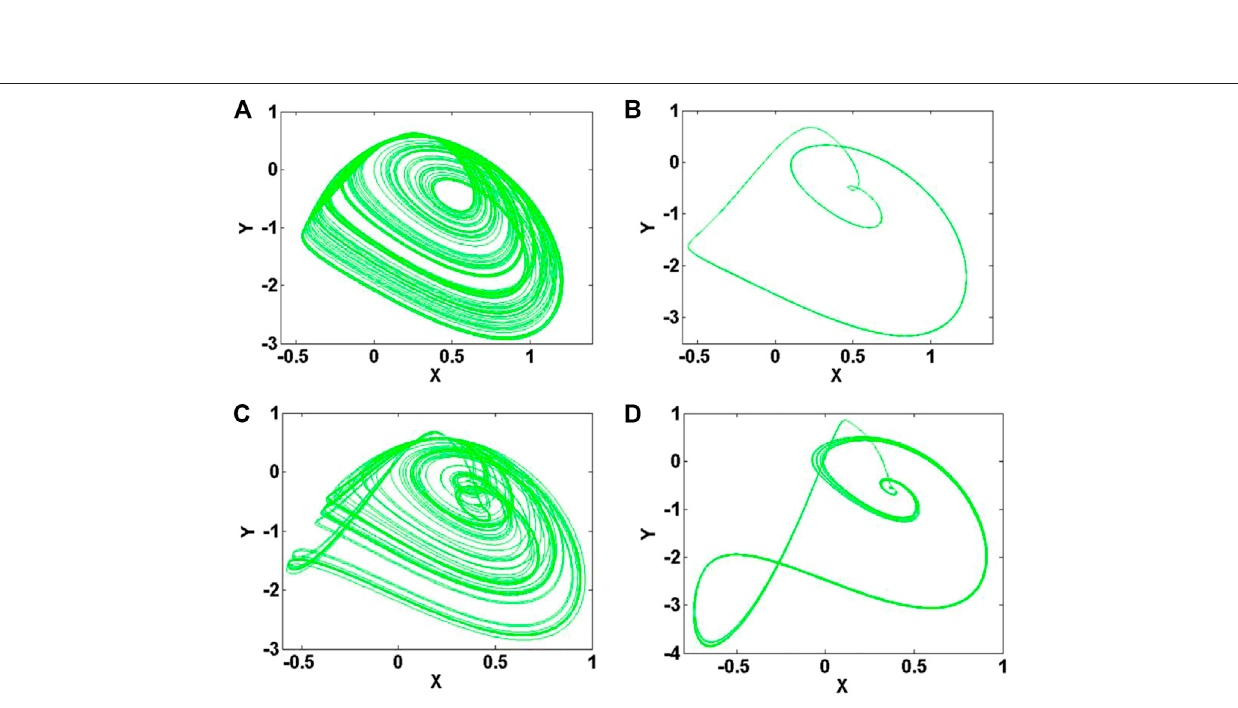
Also to observe the memristive computation in fl uence on system dynamics, here the coef fi cient d is used as a bifurcation parameter in the derived HR neuron model. When a (cid:1) 2.4, b (cid:1) 5.5, c (cid:1) 1.7, and the initial condition is (0, 0, 0), the bifurcation diagram of the maxima X of the membrane potential x and